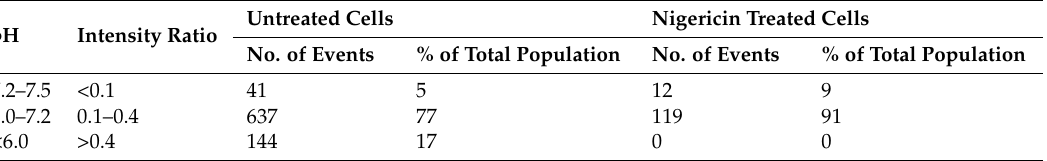
Table 3. Ratio of luminescence intensity of 590 nm to 550 nm in different cellular pH ranges before and after treatment with 20 µ M nigericin (adapted with permission from Ref. [31]. Copyright (2017) American Chemical